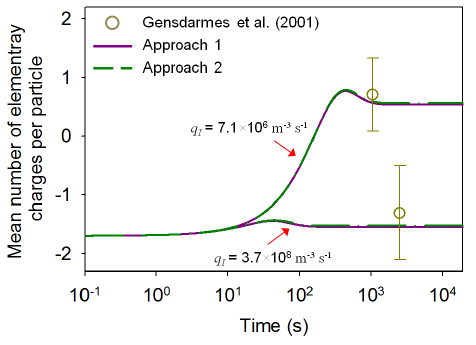
Figure 3. Charge accumulation on 137 Cs particles under two ionizing conditions: q I = 7 . 1 × 10 6 m − 3 s − 1 and q I = 3 . 7 × 10 8 m − 3 s − 1 ( d p = 0 . 82µm; A Cs-137 = 12 . 8mBq). The symbols represent the mean value of the particle charge distributions mea- sured by Gensdarmes et al.